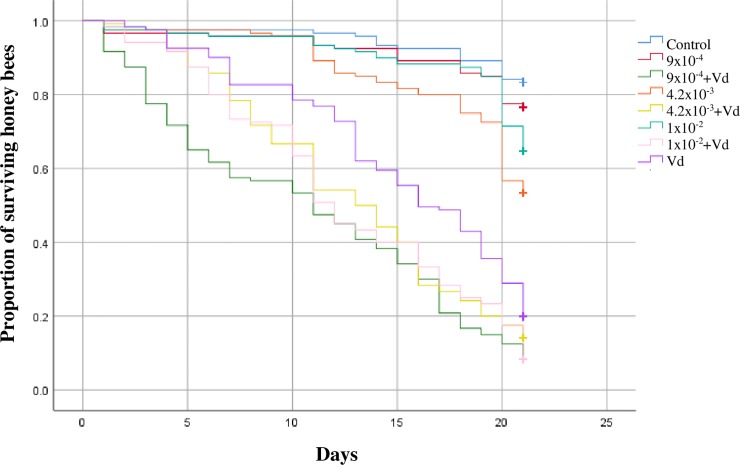
Kaplan-Meier survival curves of adult bees exposed to field realistic doses of clothianidin and/or V. destructor (Vd) for 21 consecutive days.Log rank (Mantel-Cox) tests were used to determine significant differences between survival curves (adjusted p value of 0.001).